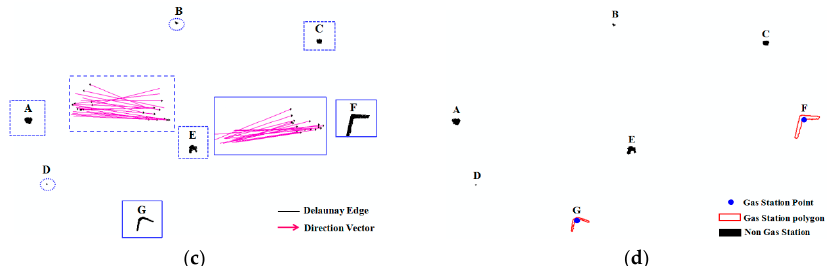
Figure 4. Refueling stop track lines clustering and gas station information extraction. ( a ) Constructing a Delaunay triangulation (DT) within interpolated stop tracks; ( b ) Removing global long edge of DT; ( c ) Non gas station deleting by gas station model; ( d ) Gas station polygon and point extraction.